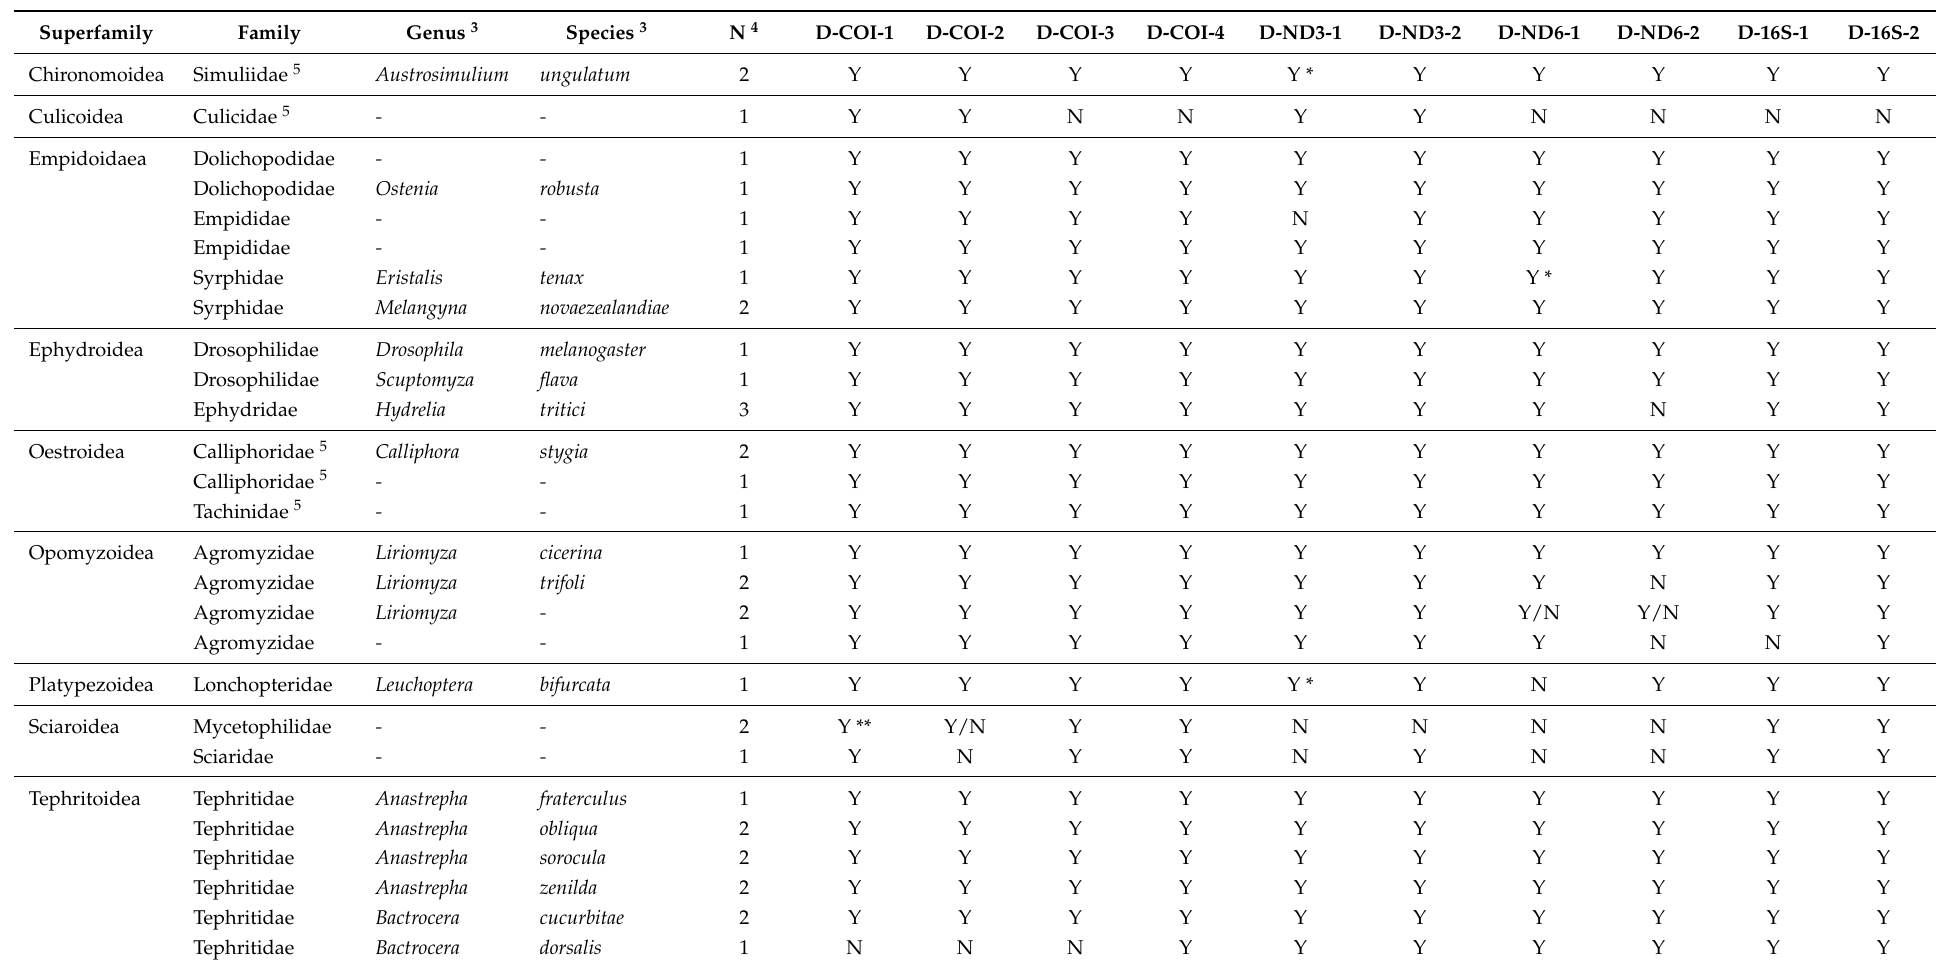
Table 4. Summary of PCR success 1 with universal primers 2 for individual specimens of